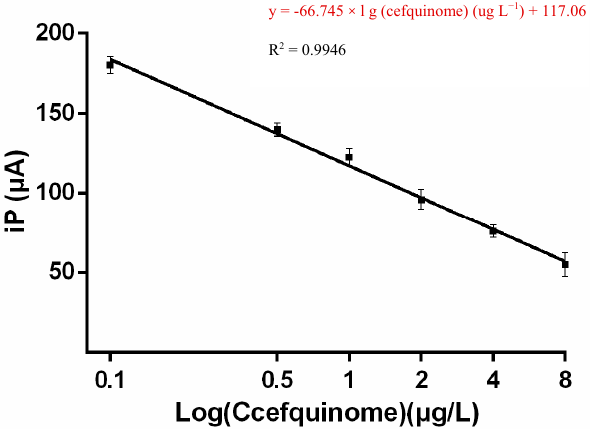
Figure 7. Standard curve for determination of Cefquinome in di ff erent concentrations by receptor sensors.